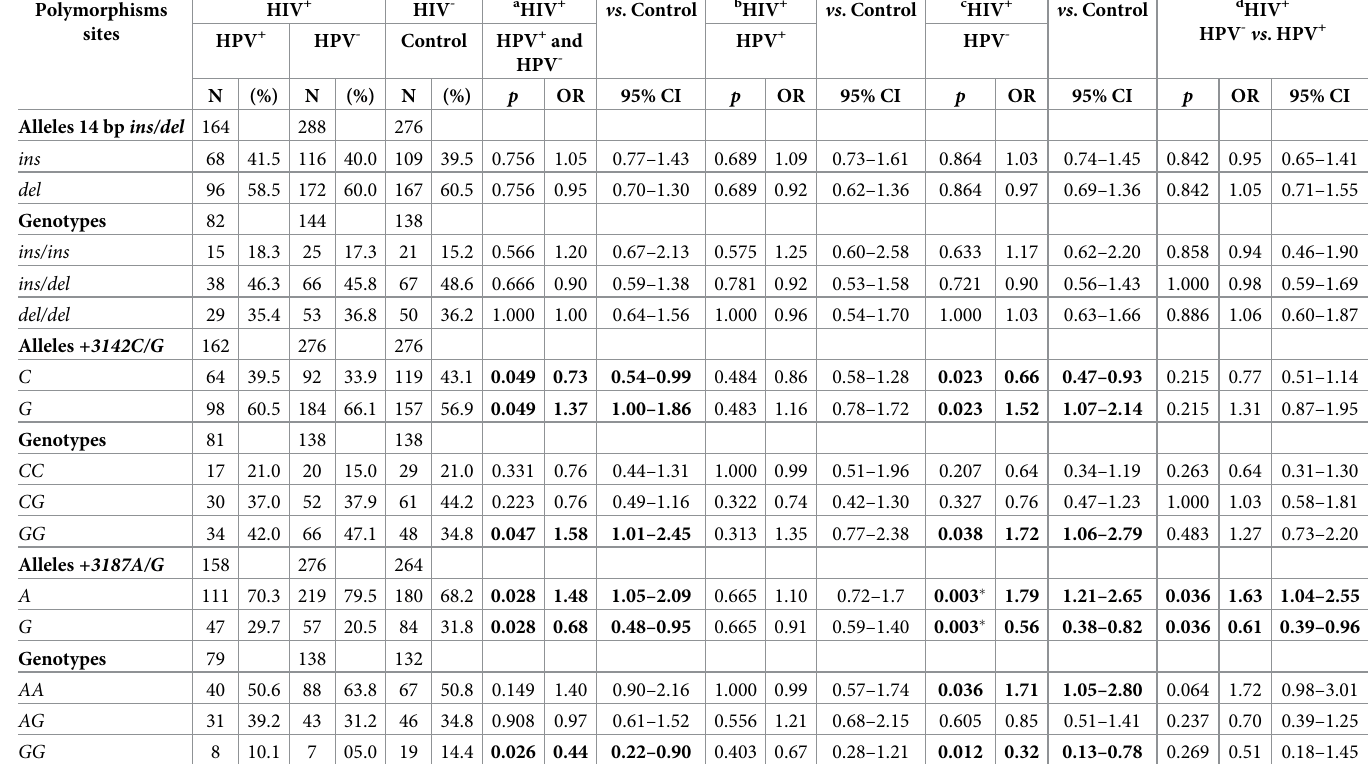
Table 2. Allelict and genotypic frequencies of HLA-G 3’ untranslated region (3’UTR) polymorphic sites of the HLA-G gene in the controls group and in HIV- infected women stratified according to the presence of HIV/HPV co-infection.